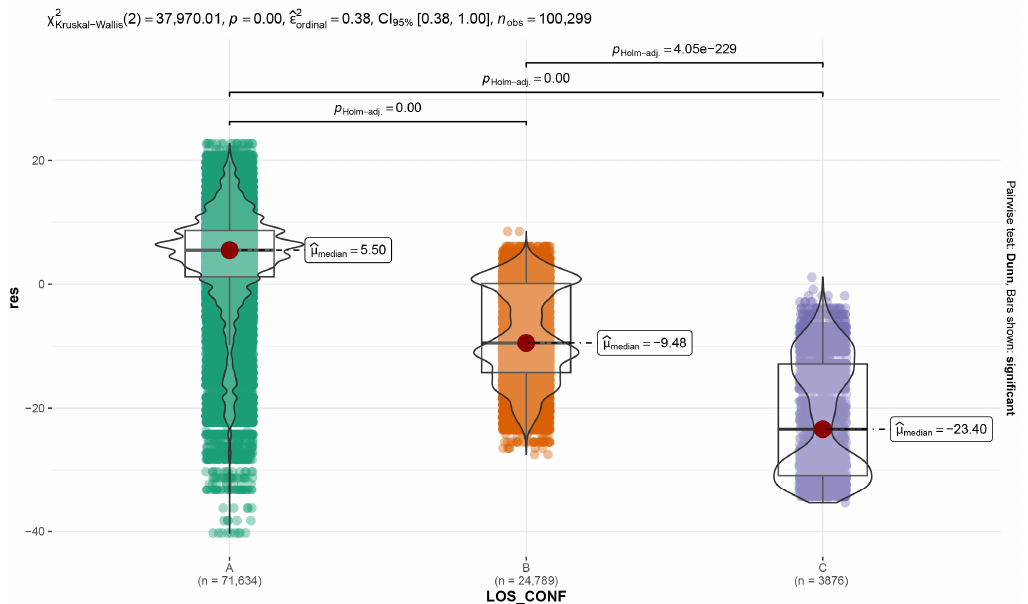
Figure 19. Kruskal–Wallis test result.